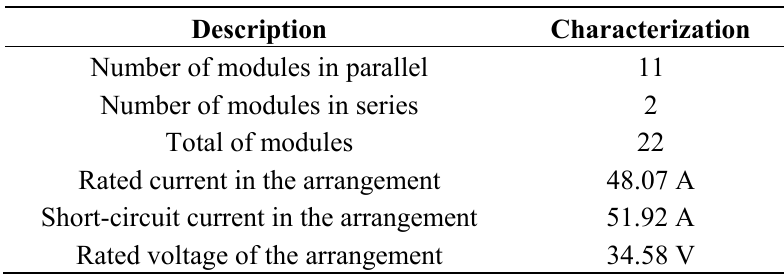
Table 5. Generator